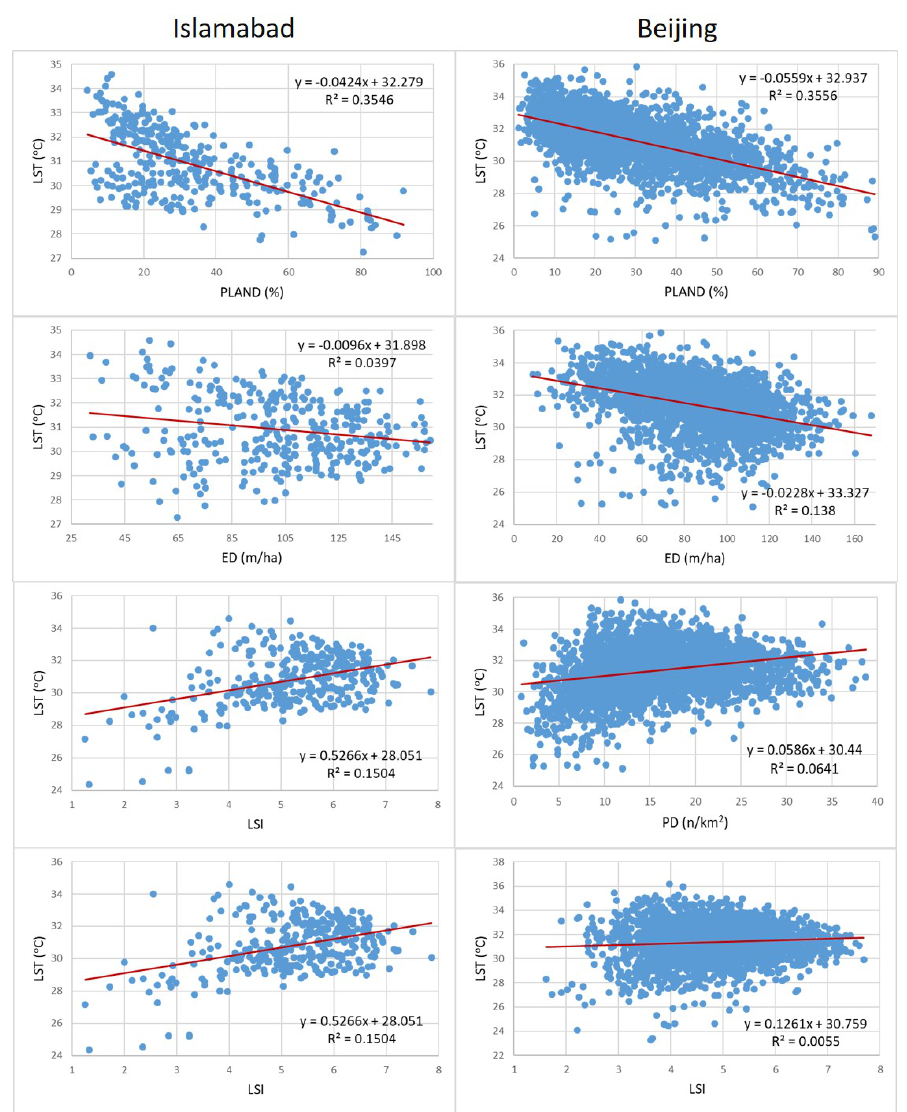
Figure 6. Correlation between LST and landscape metrics for Islamabad and